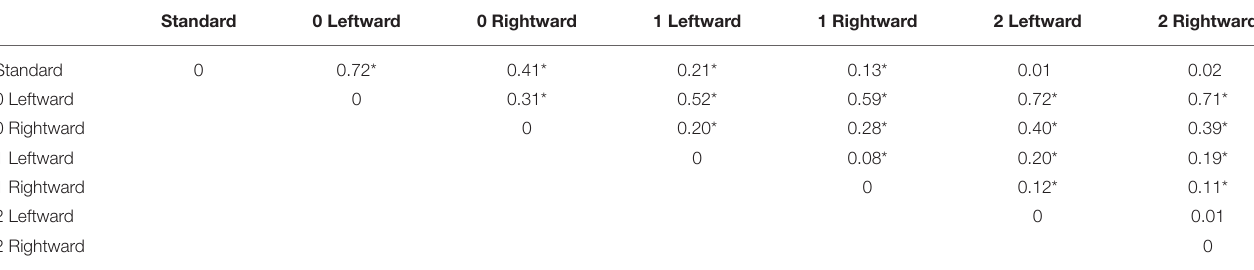
TABLE 2 | Percentage of mean difference between pairs of hierarchy categories in L1 listeners’ LD accuracy. Standard 0 Leftward 0 Rightward 1 Leftward 1 Rightward 2 Leftward 2 Rightward Standard 0